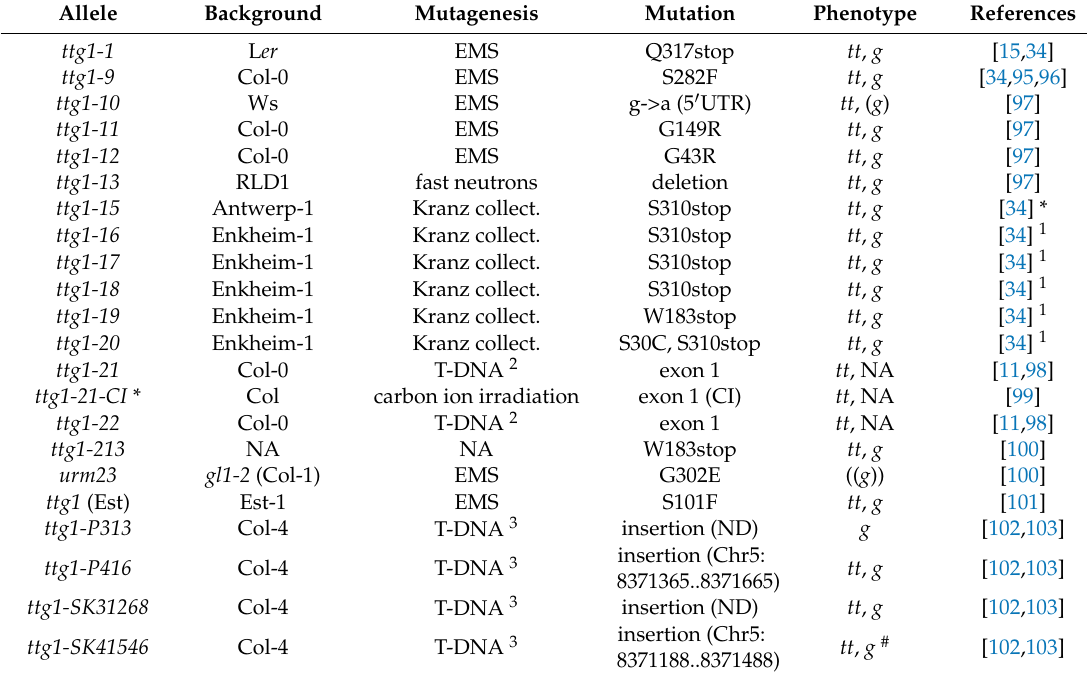
Table 1. Comprehensive list of A. thaliana ttg1 mutants with documentation on seed pigmentation. Allele Background Mutagenesis Mutation